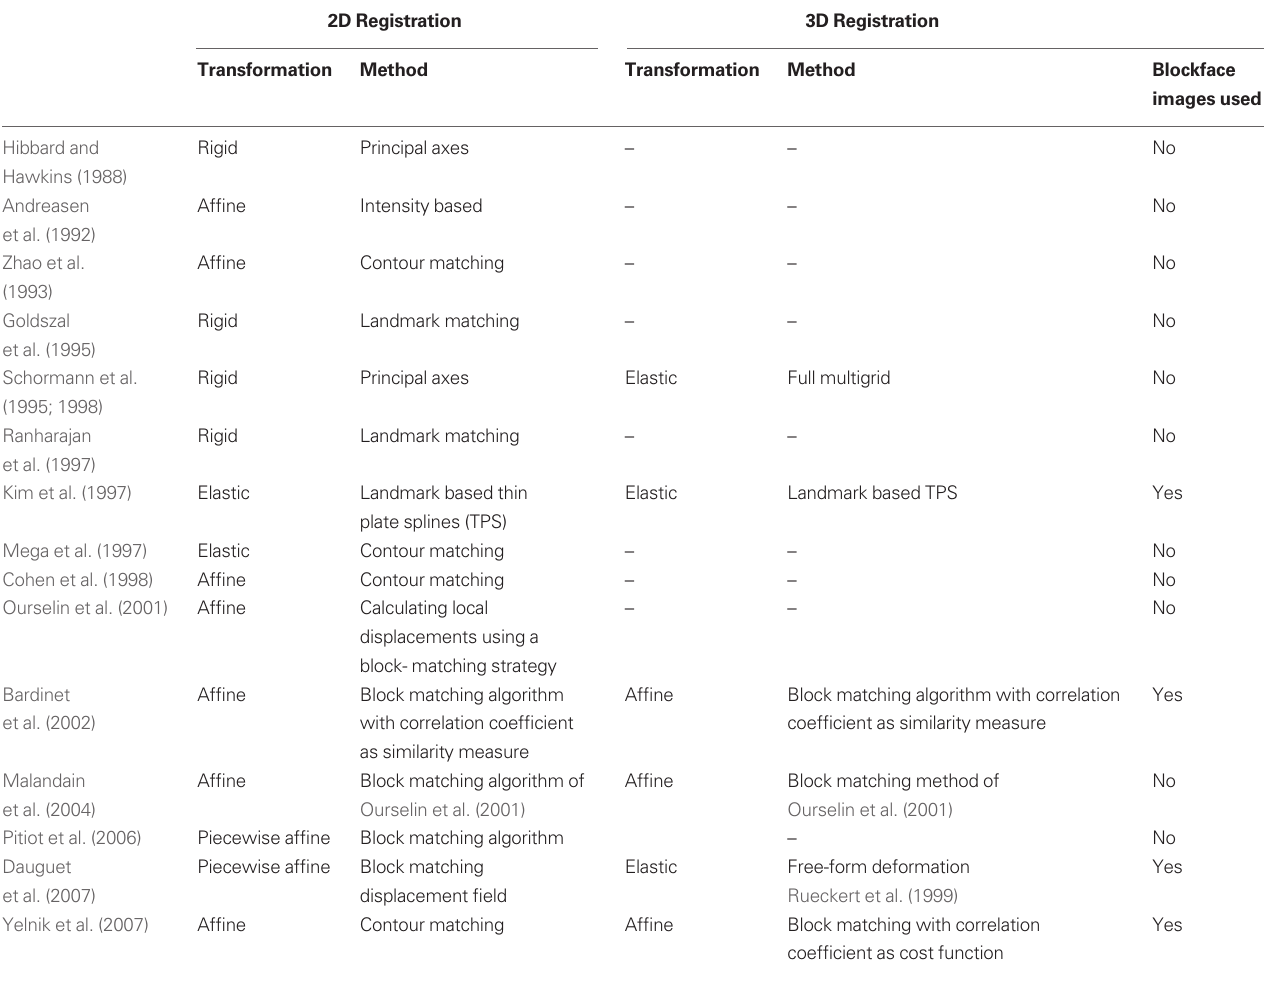
Table 1 | Summary of previous work for reconstruction of 3D histological volume and histology to in vivo modality